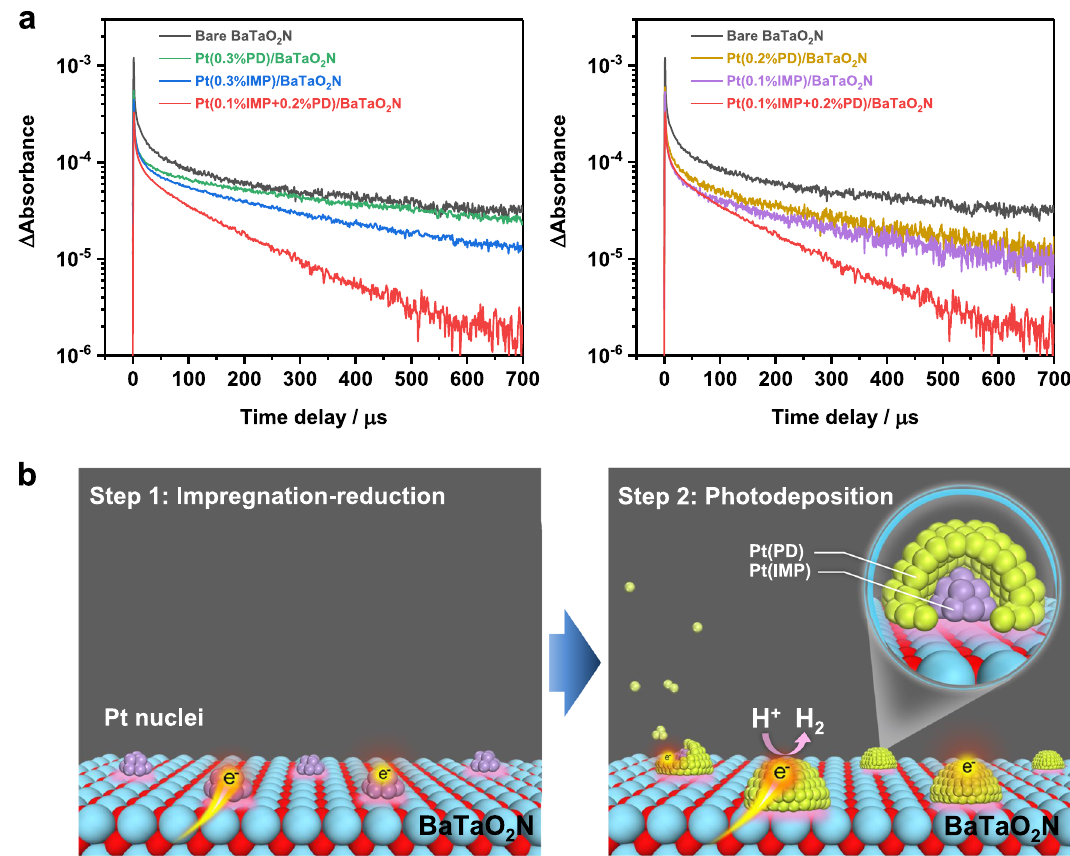
Fig. 3 Interaction of Pt nanoparticles and BaTaO 2 N (RbCl) photocatalyst. a Transient absorption decays corresponding to electron dynamics in bare BaTaO 2 N and Pt-modi fi ed BaTaO 2 N photocatalysts probed at 5000 cm − 1 (2000 nm, 0.62 eV) at 0 – 700 μ s. b Schematic of sequential Pt cocatalyst deposition on BaTaO 2